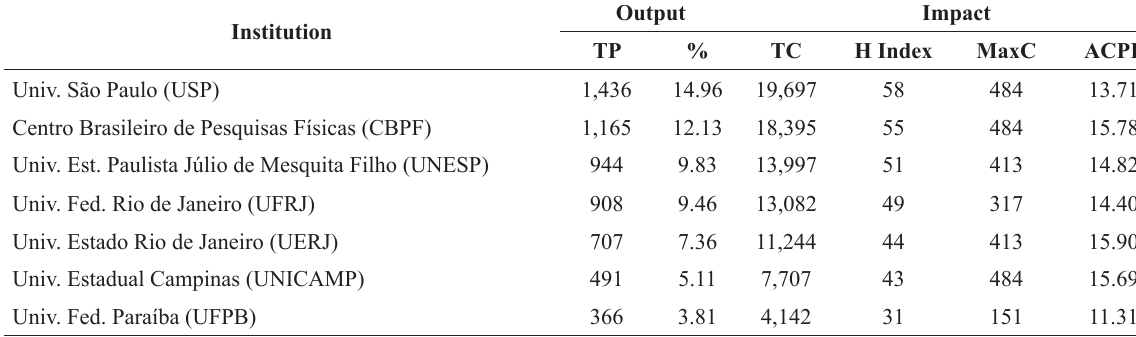
Twenty most productive institutions in Brazilian HEP,